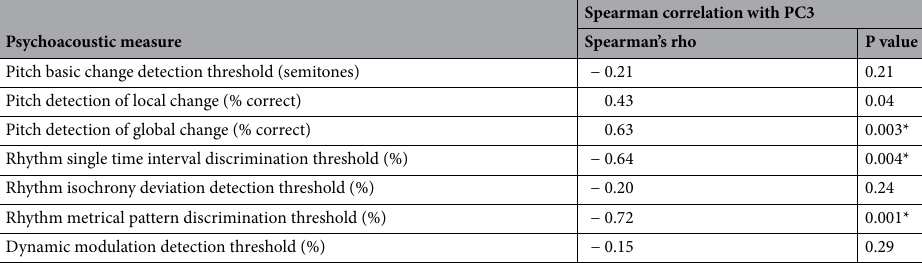
Table 3. Correlations between psychoacoustic measures and Principal Component 3 fluency. ‘P value’ corresponds to uncorrected one-sided p-values from Spearman correlations comparing psychoacoustic scores with PC3 fluency scores in the post-stroke aphasia subgroup. * indicates the p-value is significant at the Bonferroni corrected significance threshold of p < 0.007 (corrected for 7 comparisons). ‘PC’ = Principal